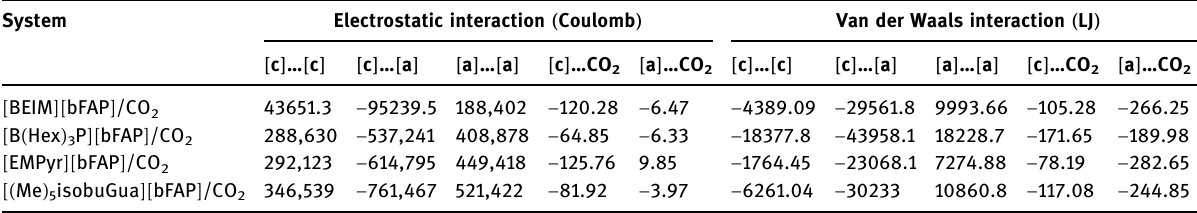
Table 3: Electrostatic and the van der Waals interaction energies computed from MD simulation ( kJ mol − 1